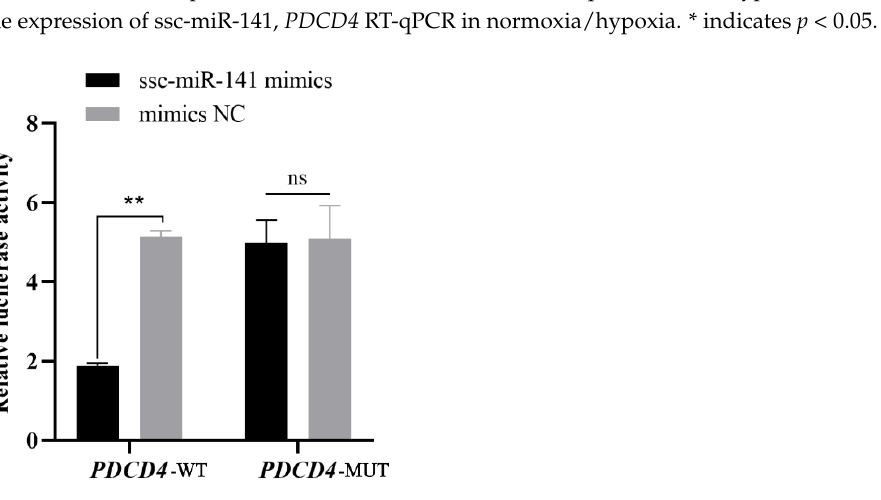
Figure 5. Double luciferase activity assays. Relative luciferase reporter expression was normalized to Negative control(NC). Each experiment was repeated three times. Data are presented as mean ± standard error. ** indicates p < 0.01 compared to mock NC; ns indicates no difference compared to mock NC (HEK-293T cells).